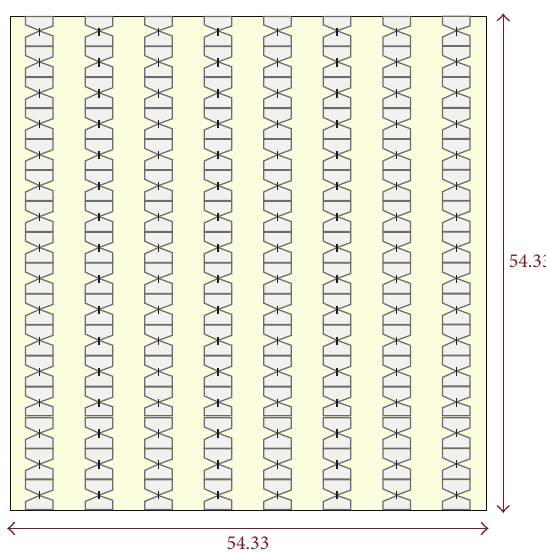
Figure 8: Dipole arrangement of the TCDA-IB array in Figure 6 forming the top of the 8 × 8 unit cell array (16 × 16 bowtie dipoles). All dimensions are in